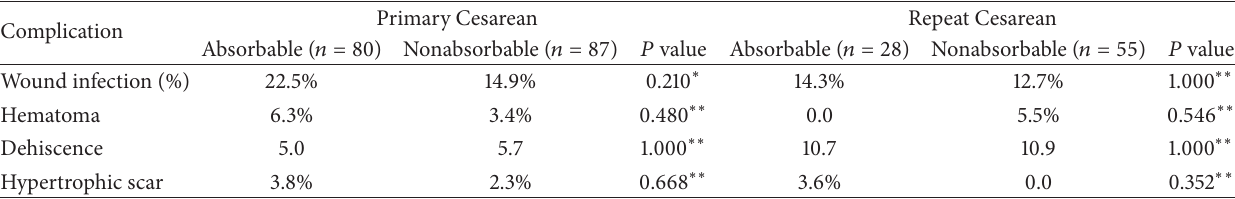
Table 2: Comparison of the groups in terms of the primary outcomes (complication